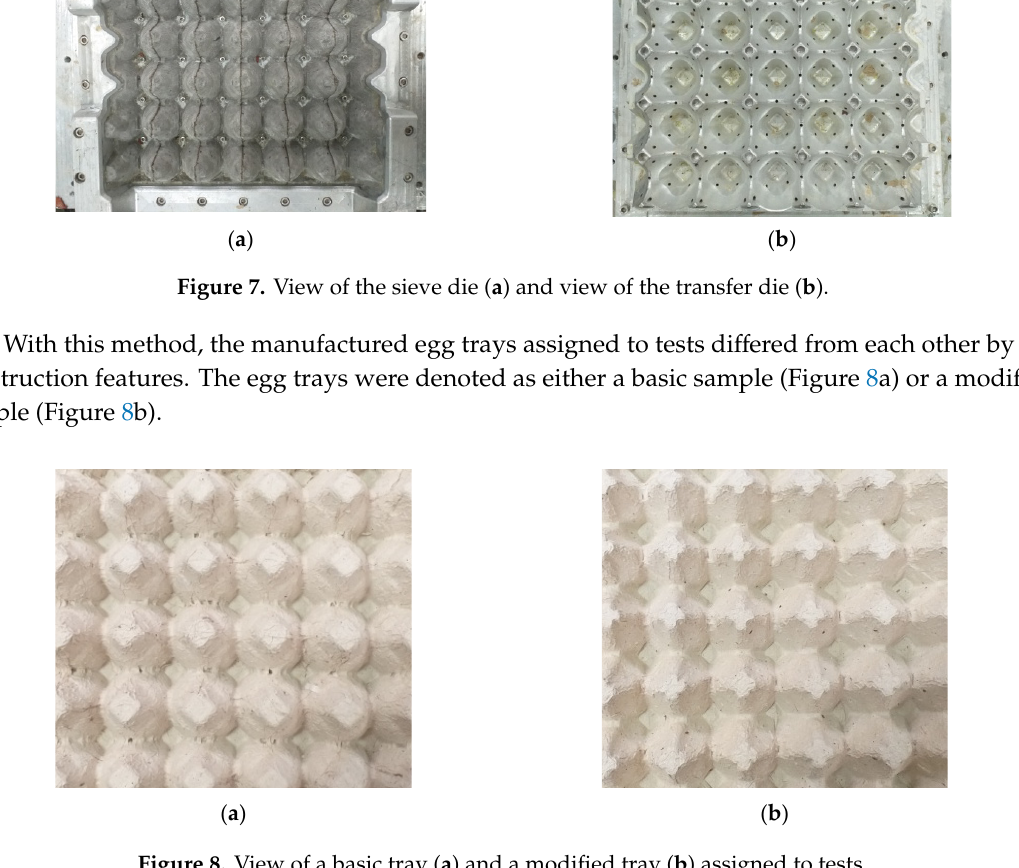
Figure 9. Zwick machine ( a ), unloaded trays in jaws before the test ( b ), and arrangement of trays under initial load ( c ).